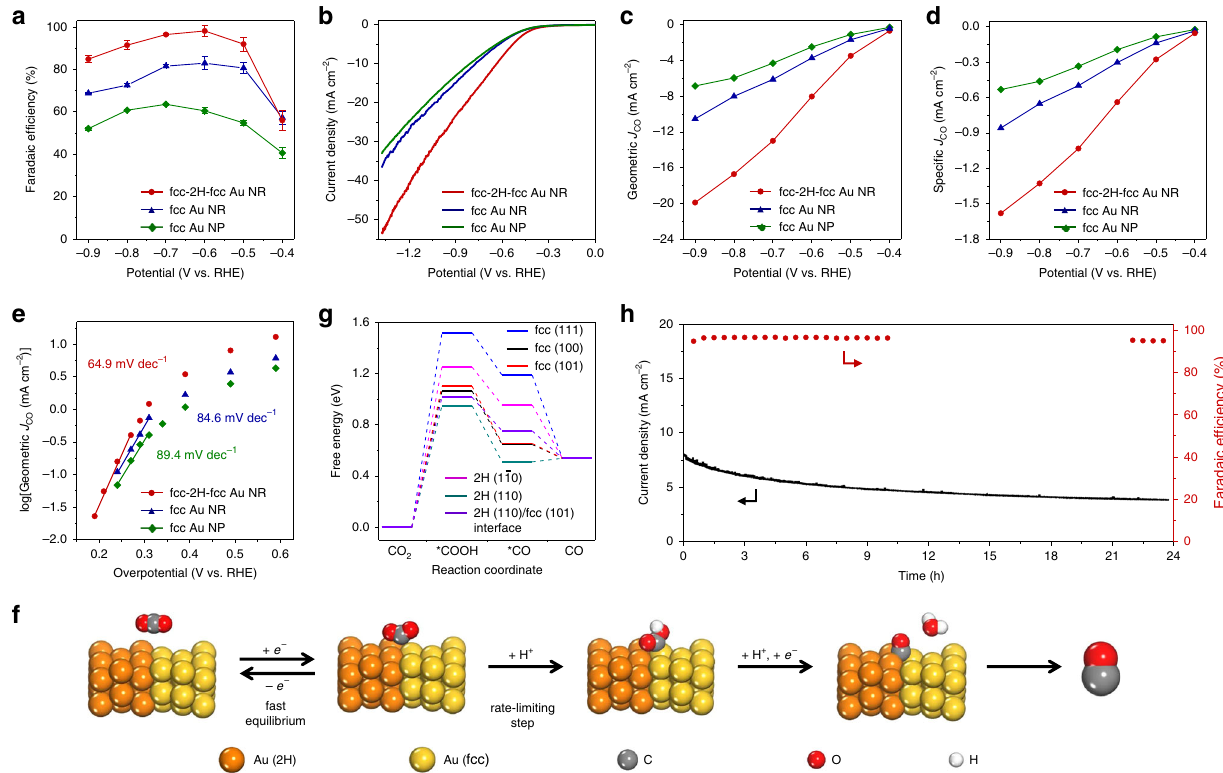
Fig. 3 Electrocatalytic performance of heterophase fcc-2H-fcc gold nanorods in carbon dioxide reduction reaction. a The CO Faradaic ef fi ciency of fcc- 2H-fcc Au NRs, fcc Au NRs and fcc Au NPs at different potentials. b LSV curves recorded in CO 2 -saturated aqueous solution of 0.5 M KHCO 3 with a scan rate of 10 mV s − 1 . c , d Partial current densities normalized by the geometric surface area of carbon electrodes ( c ) and ECSA of different Au nanostructures ( d ). e Tafel plots of fcc-2H-fcc Au NRs, fcc Au NRs and fcc Au NPs. f Schematic illustration for the CO 2 RR pathway on the regional surface of fcc-2H-fcc Au NRs. g Free energy diagrams for CO 2 reduction via the formation of *COOH to produce CO on different surfaces, including the 2H (110), 2H (110)/fcc (101) interface, 2H (1 (cid:1) 10), fcc (100), fcc (101) and fcc (111). h Electrocatalytic stability test of fcc-2H-fcc Au NRs at applied potential of − 0.6 V (vs. RHE). The CO Faradaic ef fi ciency was analysed every half an hour in the fi rst 10 h and the last 2 h as